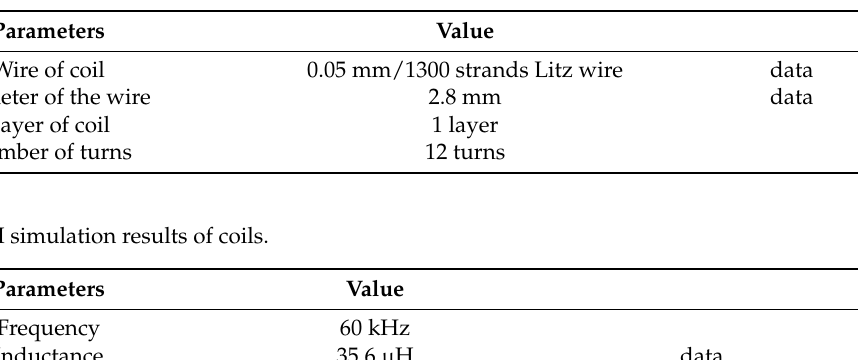
Figure 12. WPT coils designed by an electromagnetic field simulator: ( a ) bird’s eye view; ( b ) top view. Table 3. Structural and material specifications of WPT coils.